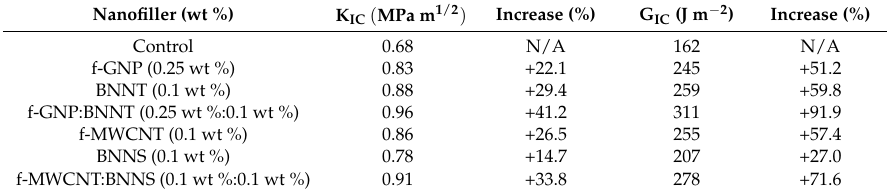
Nanofiller (wt %) Table 5. Variation of K IC and G IC for the hybrid nanocomposites relative to the neat epoxy.